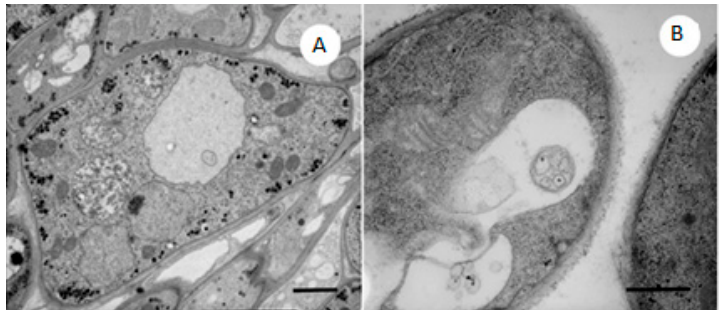
Figure 5. ( A ) M. gypseum control with normal mitochondria, nuclei and ribosomes. Note the glycogen rosettes near the plasmalemma. TEM. Scale bar: 1 μ m; ( B ) M. gypseum treated with 20 μ g/mL